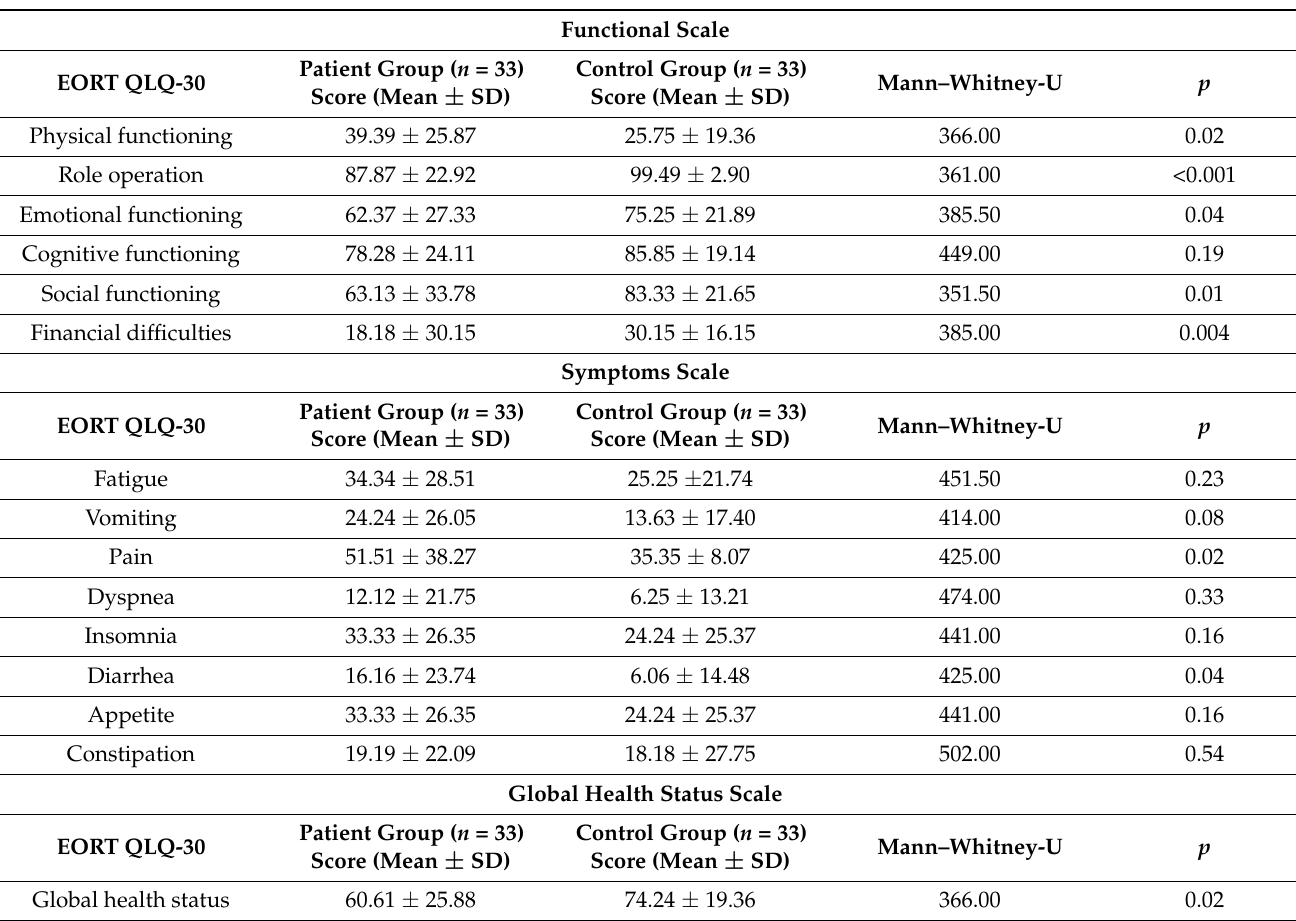
Table 4. EORTC QLQ-30 scores.